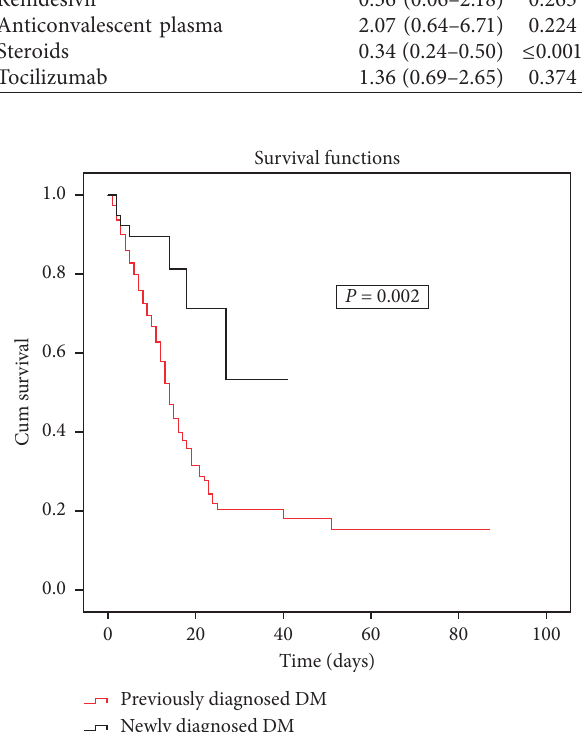
Figure 2: Kaplan–Meier survival curve comparing the two groups of previously diagnosed and newly diagnosed type-2